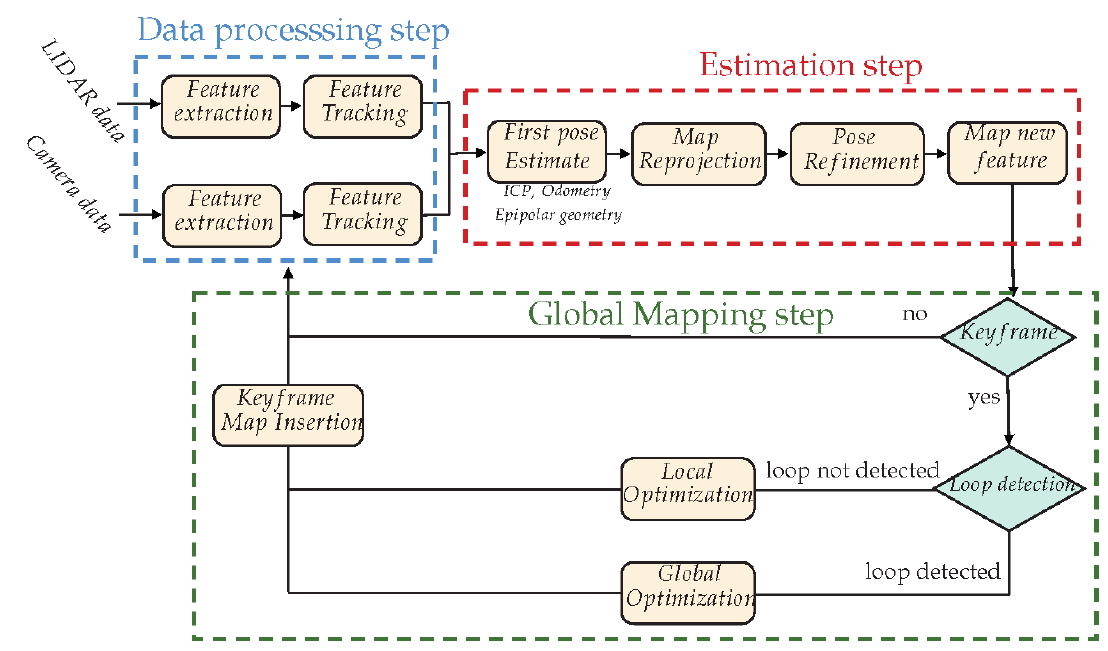
Figure 8. Proposed Hybridized SLAM global framework. The proposed framework follows a classical SLAM architecture with three main steps: (1) The data processing step, (2) the estimation and (3) the global mapping